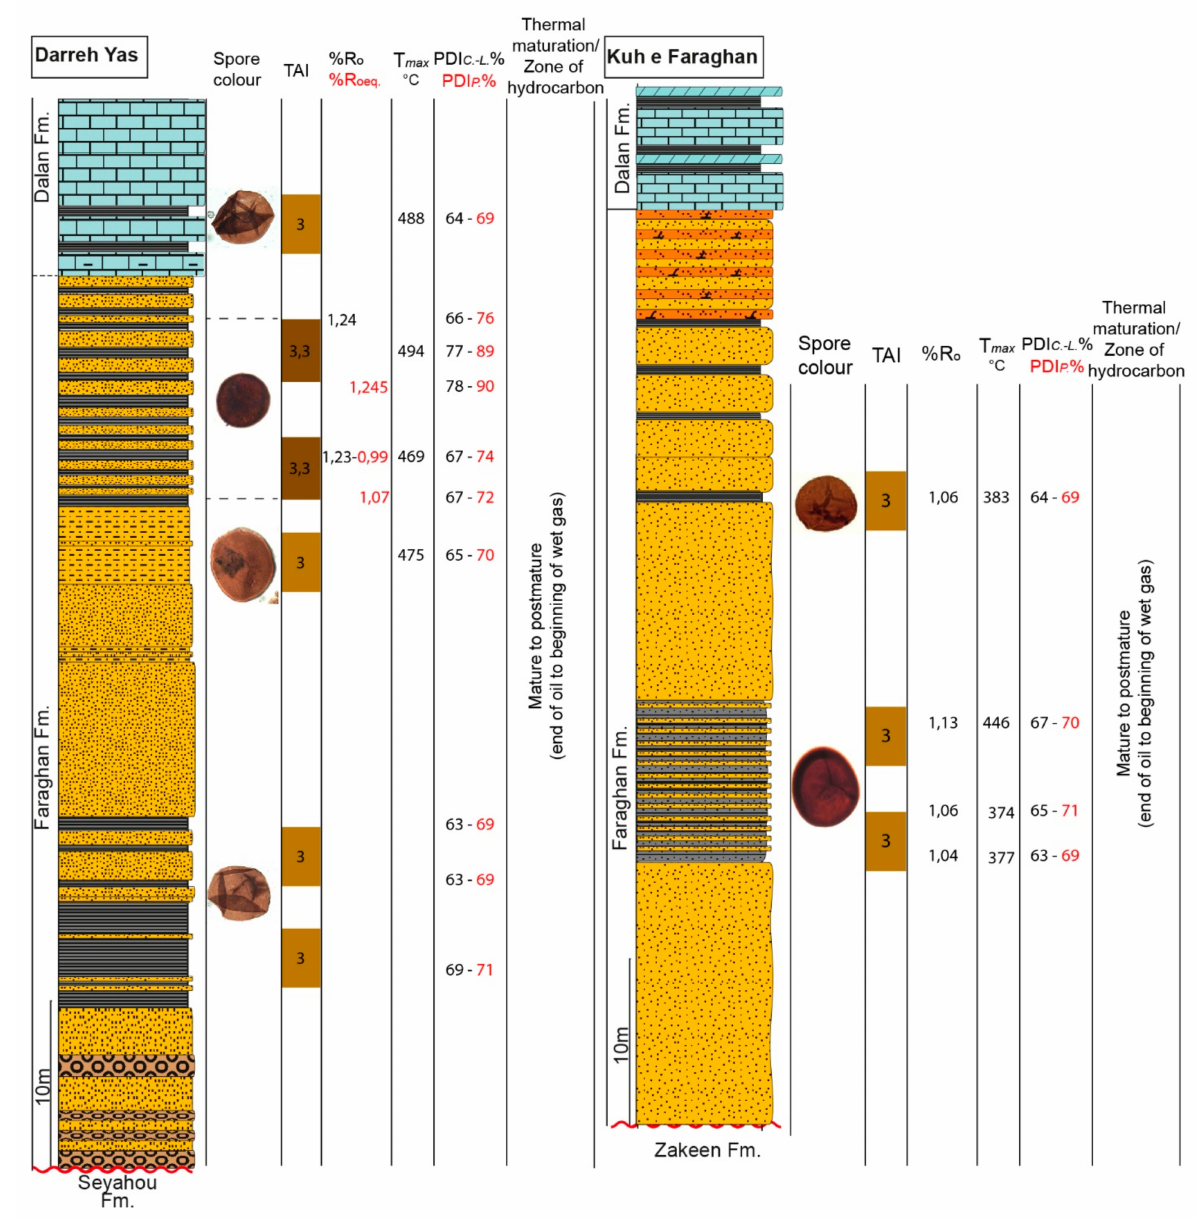
Figure 8. Lithology, sampled horizons and thermal maturity data for the Faraghan Formation at the Darreh Yas and Kuh e Faraghan